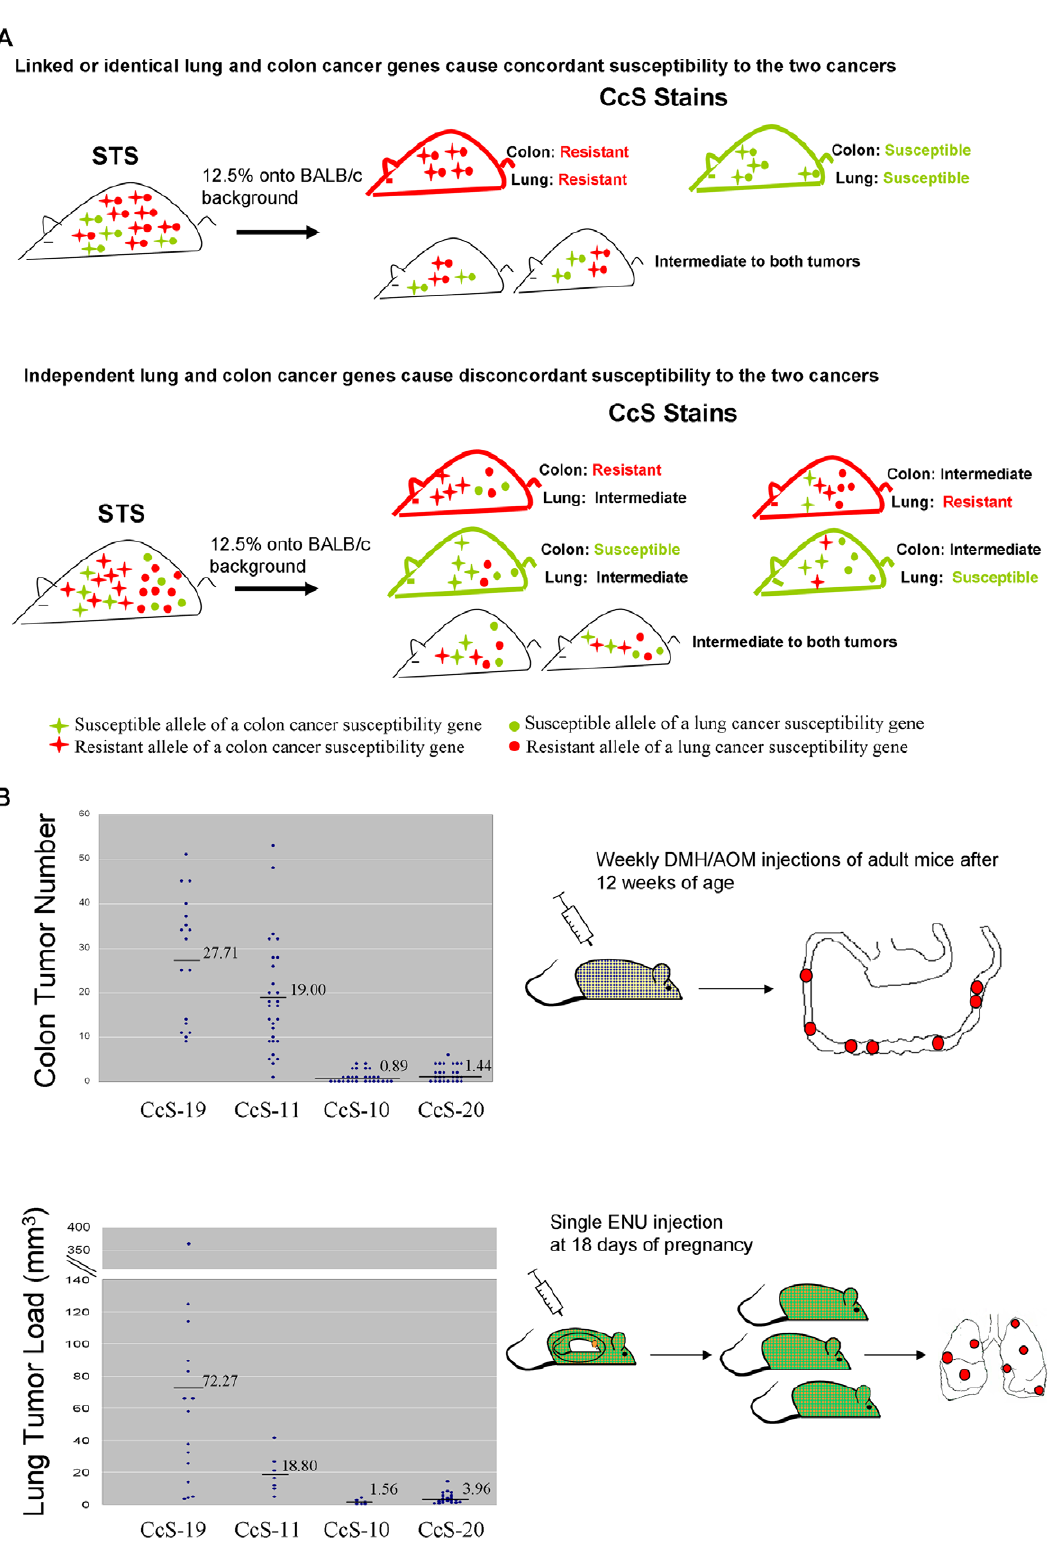
Figure 2. Correlated lung and colon cancer susceptibility in the CcS RC strains. A. Expected susceptibility to colon and lung tumors under different hypotheses. Concordant susceptibility or resistance to colon and lung tumors is expected when the majority of the susceptibility genes of the two cancers are closely linked or identical (upper panel); but not when the susceptibility genes of the two cancers are independent of each other (lower panel). B. Observed susceptibility to colon and lung tumors in the CcS RC strains with extreme susceptibility phenotype. Each dot represents a mouse. Mean tumor number of each strain is indicated. Upper panel: colon tumor numbers for CcS-19, CcS-11, CcS-10 and CcS-20 mice. Colon tumor number is directly proportional to colon tumor load, since in our experiments colon tumor sizes did not differ significantly among the CcS strains [35].